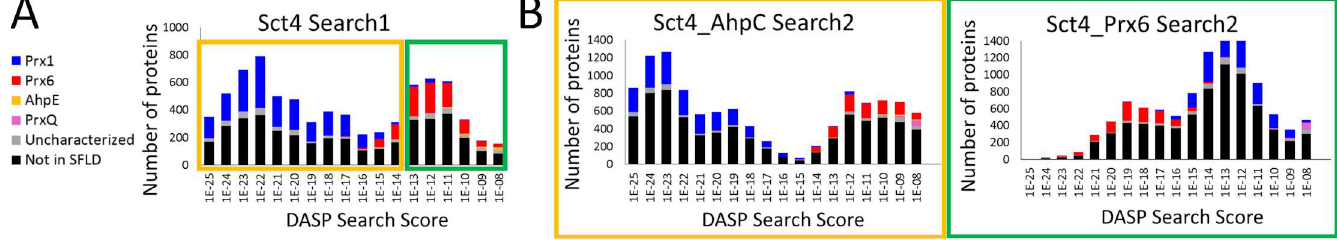
Fig 8. PSSM Analysis subdivides Sct4 into Prx1 and Prx6 groups based on distinctive active site features. (A) A score distribution of the Sct4 Search1 results is shown with bars colored basedon known functionalannotation. The yellow and green boxes identify the groups distinguished by PSSM Analysis. (B) Search2 score distributions show the results of the subsequent MISST iteration, in which profiles of sequencesin each of the yellow and green boxes were created and used in separate searches.